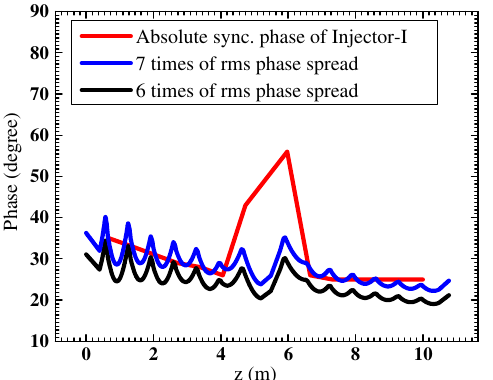
FIG. 11. The synchronous phase (absolute value) evolution (red) and 6 times (black) and 7 times (blue) of the rms phase spread evolution of the Injector I SC